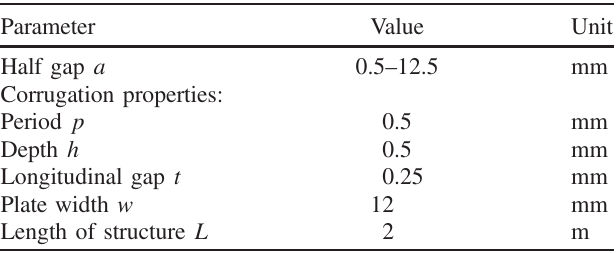
TABLE I. Parameters of the RadiaBeam/SLAC dechirper.